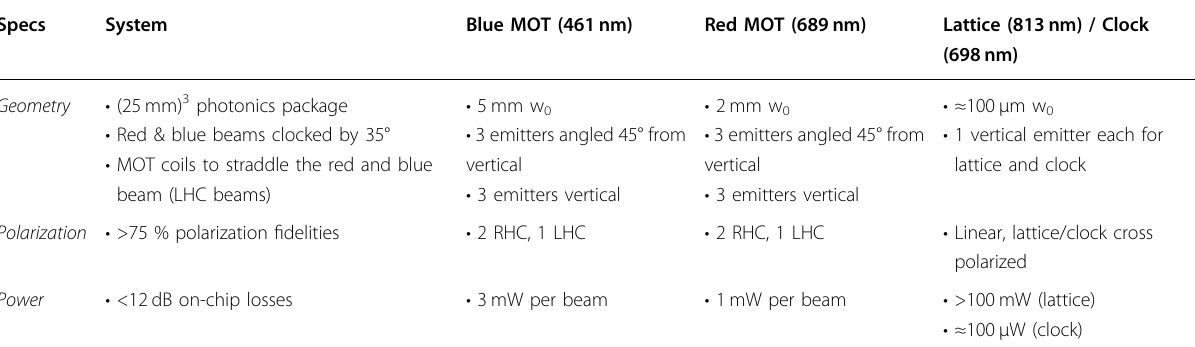
Table 1 MOT and atomic clock system speci fi